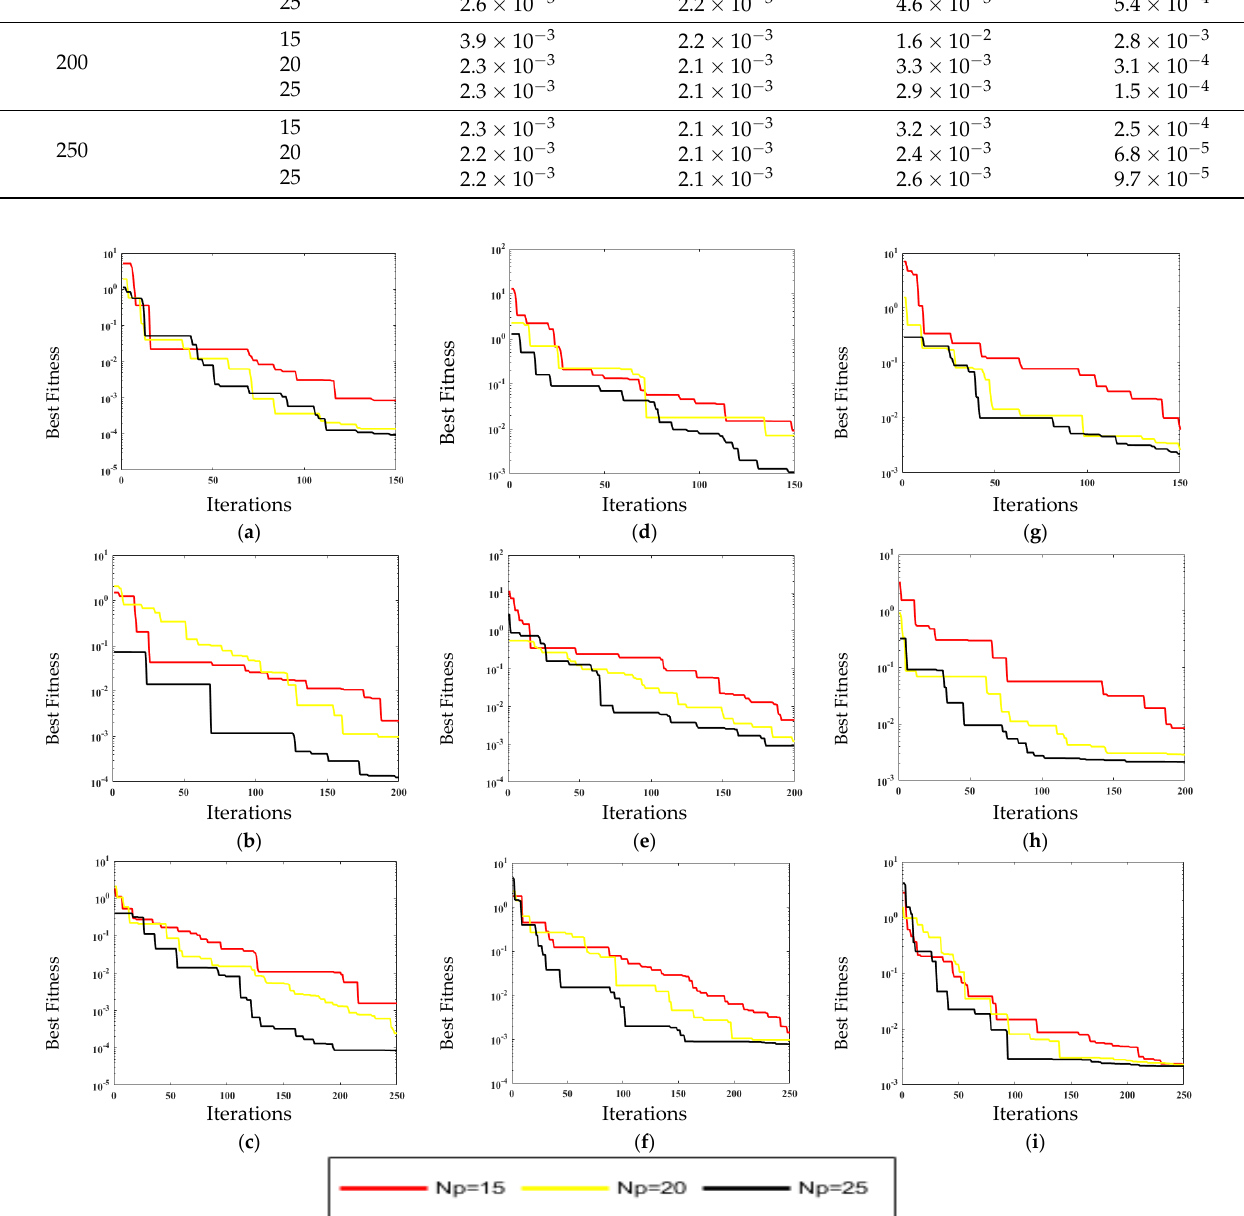
Figure 3. Fitness plots for the DMOA w.r.t population sizes. ( a – c ) Noise = 0.01 ( d – f ) Noise = 0.03 ( g – i ) Noise = 0.05. ( g – i ) Noise =